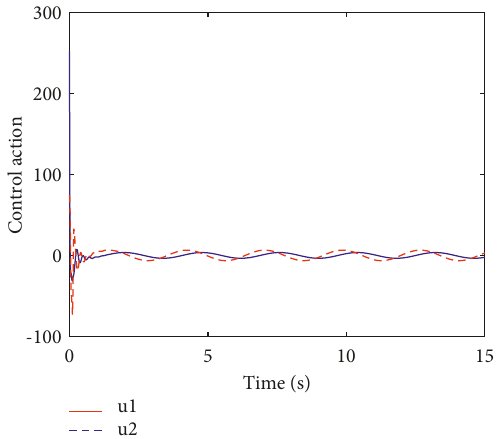
Figure 16: The required control input for q